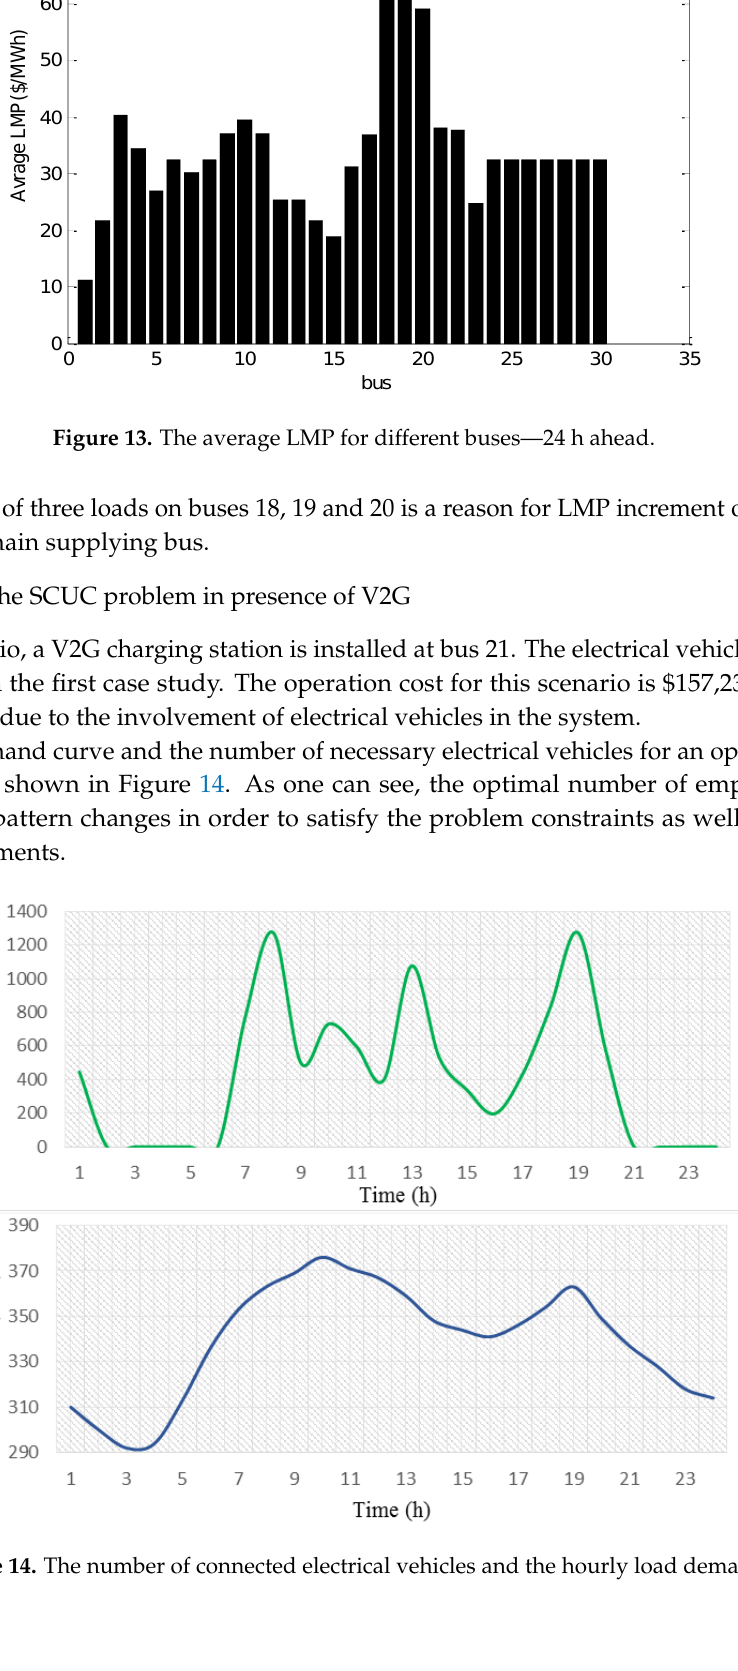
13 of 17 Figure 12. The load demand curve for the 30-bus system — 24 h ahead.